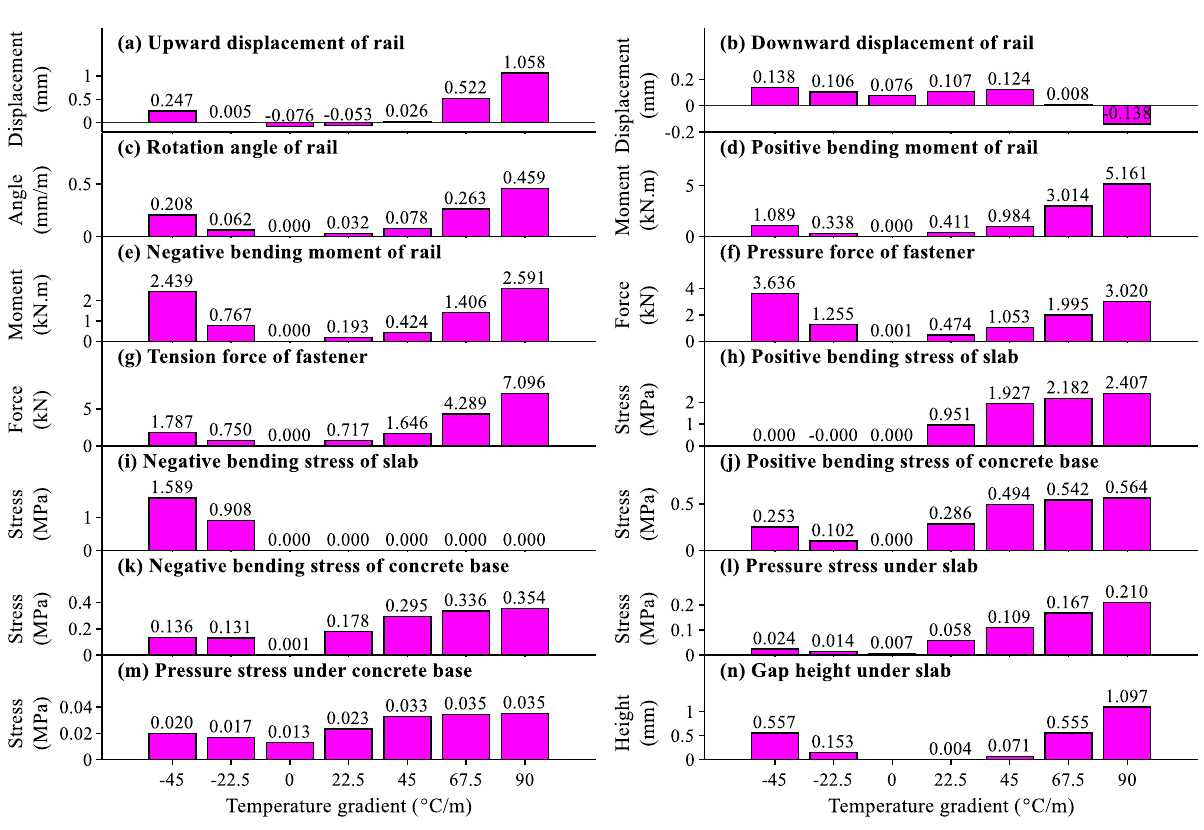
Figure 6. The relation between the temperature gradient of slab track and maximum initial values for different